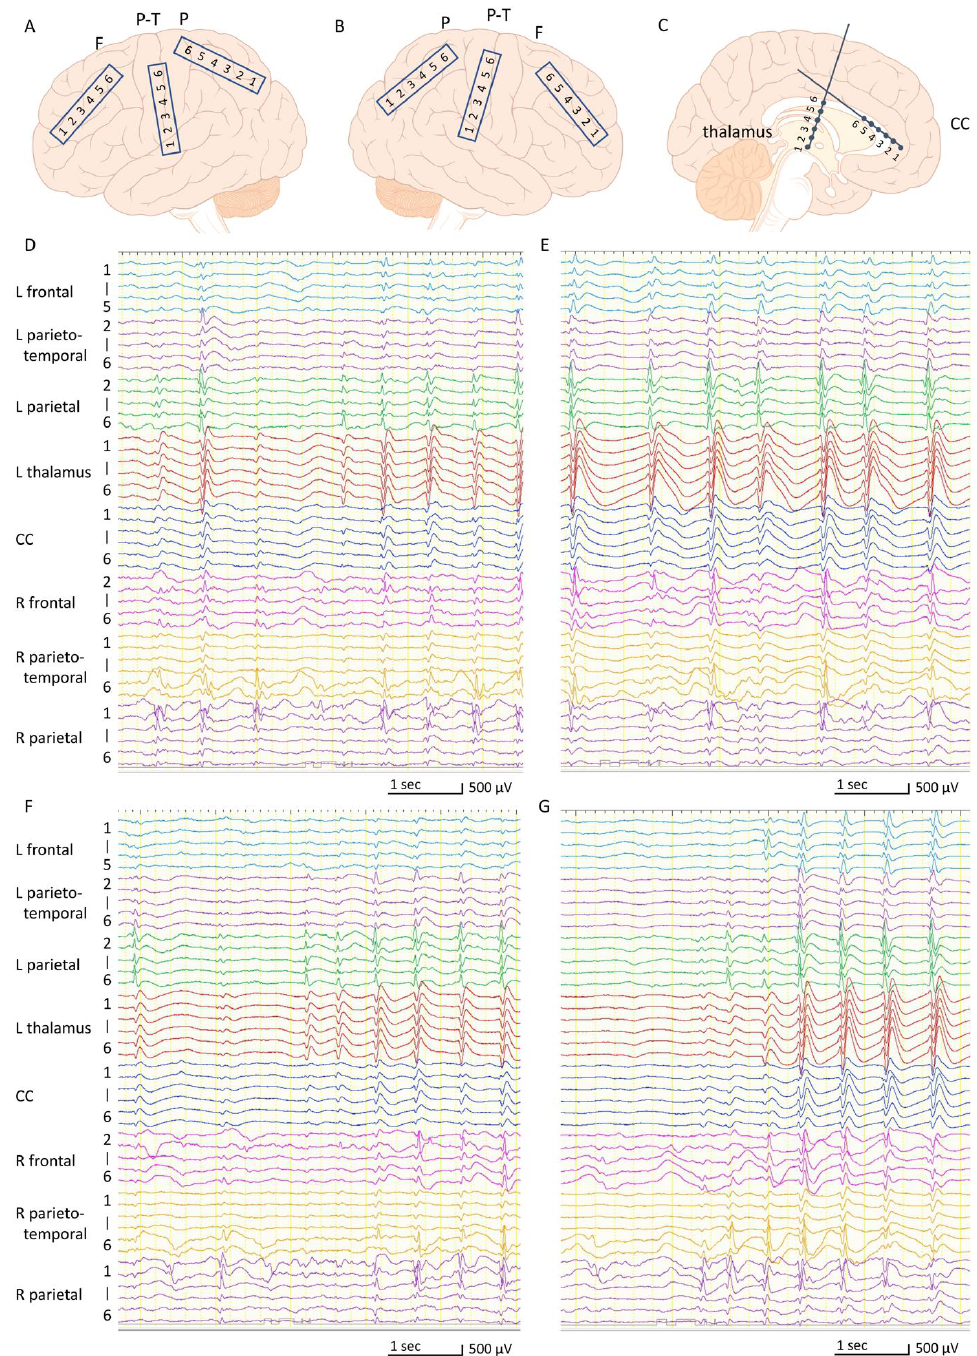
Figure 3. Intracranial electroencephalograms (EEGs) at 5 years of age. All EEGs were recorded with the following settings: low-cut filter, 1.6 Hz; high-cut filter, 60 Hz. All EEGs are displayed in a referential montage, with the referential electrode placed on the forehead. EEGs recorded by strip electrode No. 6 placed in the left frontal lobe, No. 1 in the left parieto- temporal lobe, No. 1 in the left parietal lobe, and No. 1 in the right frontal lobe were removed due to the poor quality of the recording. ( A – C ) Schemes indicating the placement of the subdural strip and depth electrodes. ( D ) Interictal sleep EEG. Epileptiform discharges are observed predominantly in the electrodes placed over the left parietal, right parietal, and right parieto-temporal lobes. Epileptiform discharges are also found in the left thalamus, but are preceded by those from the left or right parietal lobe. ( E ) Interictal sleep EEG. Epileptiform discharges are widespread over both hemispheres, the left thalamus, and the corpus callosum. ( F , G ) Ictal EEG of an absence seizure. Most ictal EEG changes started from the left parietal lobe ( F ) and often from the right parietal lobe as well ( G ). Abbreviations: CC, corpus callosum; F, frontal lobe; P, parietal lobe; P-T, parieto-temporal